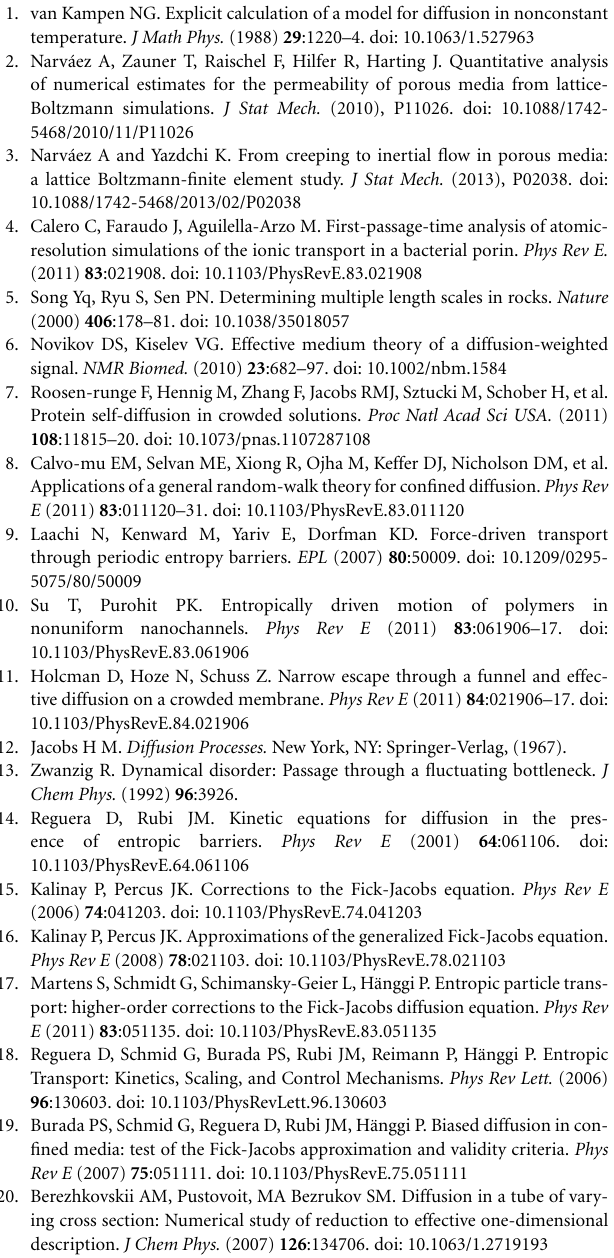
only at smaller (cid:3) S the different behavior upon variation of h 0 , h